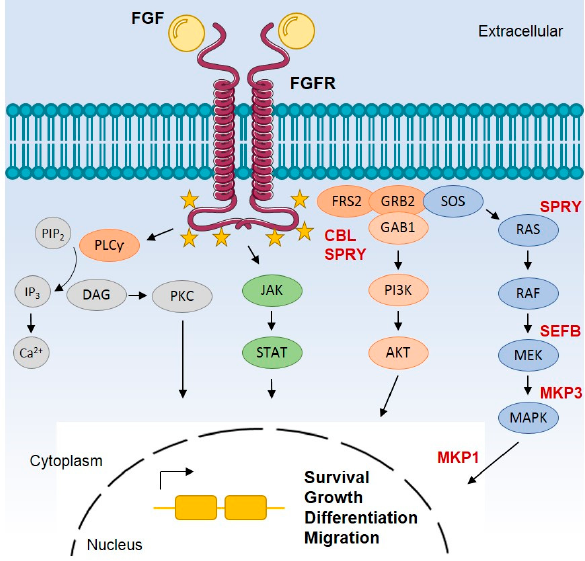
Figure 1. Simplified overview of FGFR canonical signalling pathways. FGFs bind to FGFR inducing receptor dimerisation which then drives the transphosphorylation of the tyrosine kinase domain in the intracellular compartment of the cell. The intracellular portion of active FGFR is phosphorylated at multiple tyrosine sites. In the C-terminus, tyrosine phosphorylation acts as a docking site for molecules containing SH2 domains such as PLC γ . Phosphorylation of PLC γ hydrolyses PIP2 to produce DAG and IP3, inducing the release of calcium cations and subsequent activation of PKC. In the intracellular juxtamembrane region of FGFR, phosphorylation leads to the recruitment of FRS2 which then acts as a secondary docking protein to form two independent complexes. One complex is FRS2-GRB2-SOS that activates RAS, which in turn activates the MAPK pathway. A second complex is FRS2-GRB2-GAB1, which drives the activation of PI3K/AKT pathway. Other pathways are also known to be activated by FGFR such as STAT, p38 MAPK, JNK, SRC and RSK2 pathways. Collectively, these pathways play multiple roles in cell survival, growth, migration, differentiation and metabolism. FGFR signalling is regulated by receptor internalisation upon ubiquitination by CBL or by negative modulation by different proteins (shown in bold red) such as MKP, SEF and SPRY. The yellow stars represent tyrosine phosphorylation sites. HS: heparin sulphate; FRS2: FGFR substrate 2; PLC γ : protein phospholipase C γ ; PIP2: phosphatidylinositol 4,5-bisphosphate; DAG: diacylglycerol; IP3: IP3 inositol 1,4,5-triphosphate; Ca 2+ : calcium; PKC: protein kinase C; GRB2: growth factor receptor-bond 2; SOS: son of sevenless; MAPK: mitogen-activated protein kinase; PI3K: phosphoinositide 3-kinase; MEK: intracellular mitogen-activated protein kinase/Erk kinase; RAF: Raf-1 proto-oncogene, serine/threonine kinase; RAS: proto-oncogene GTPase; GAB1: GRB2- associated binding protein 1; AKT: Akt serine/threonine kinase 1; JAK: janus kinase; STAT: signal transducer and activator of transcription; CBL: Cbl proto-oncogene E3 ubiquitin protein ligase; MKP: MAPK phosphatases; SEF: similar expression to fgf genes; SPRY: sprouty homolog.